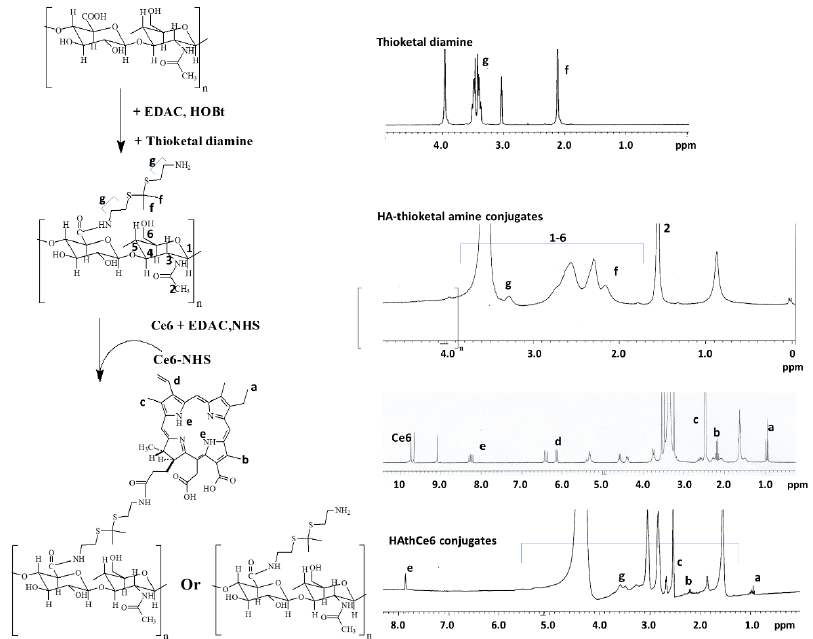
Figure 1. Synthesis scheme ( left ) and 1 H NMR spectra ( right ) of HAthCe6 conjugates. The dimethyl sulfoxide (DMSO) ‐ d form was used to dissolve Ce6 or thioketal diamine, and dimethyl sulfoxide (DMSO) ‐ d form/D 2 O (4/1, v / v ) mixtures were used to dissolve HA or HAthCe6 conjugates. Table 1. Characterization of HAthCe6 conjugates.